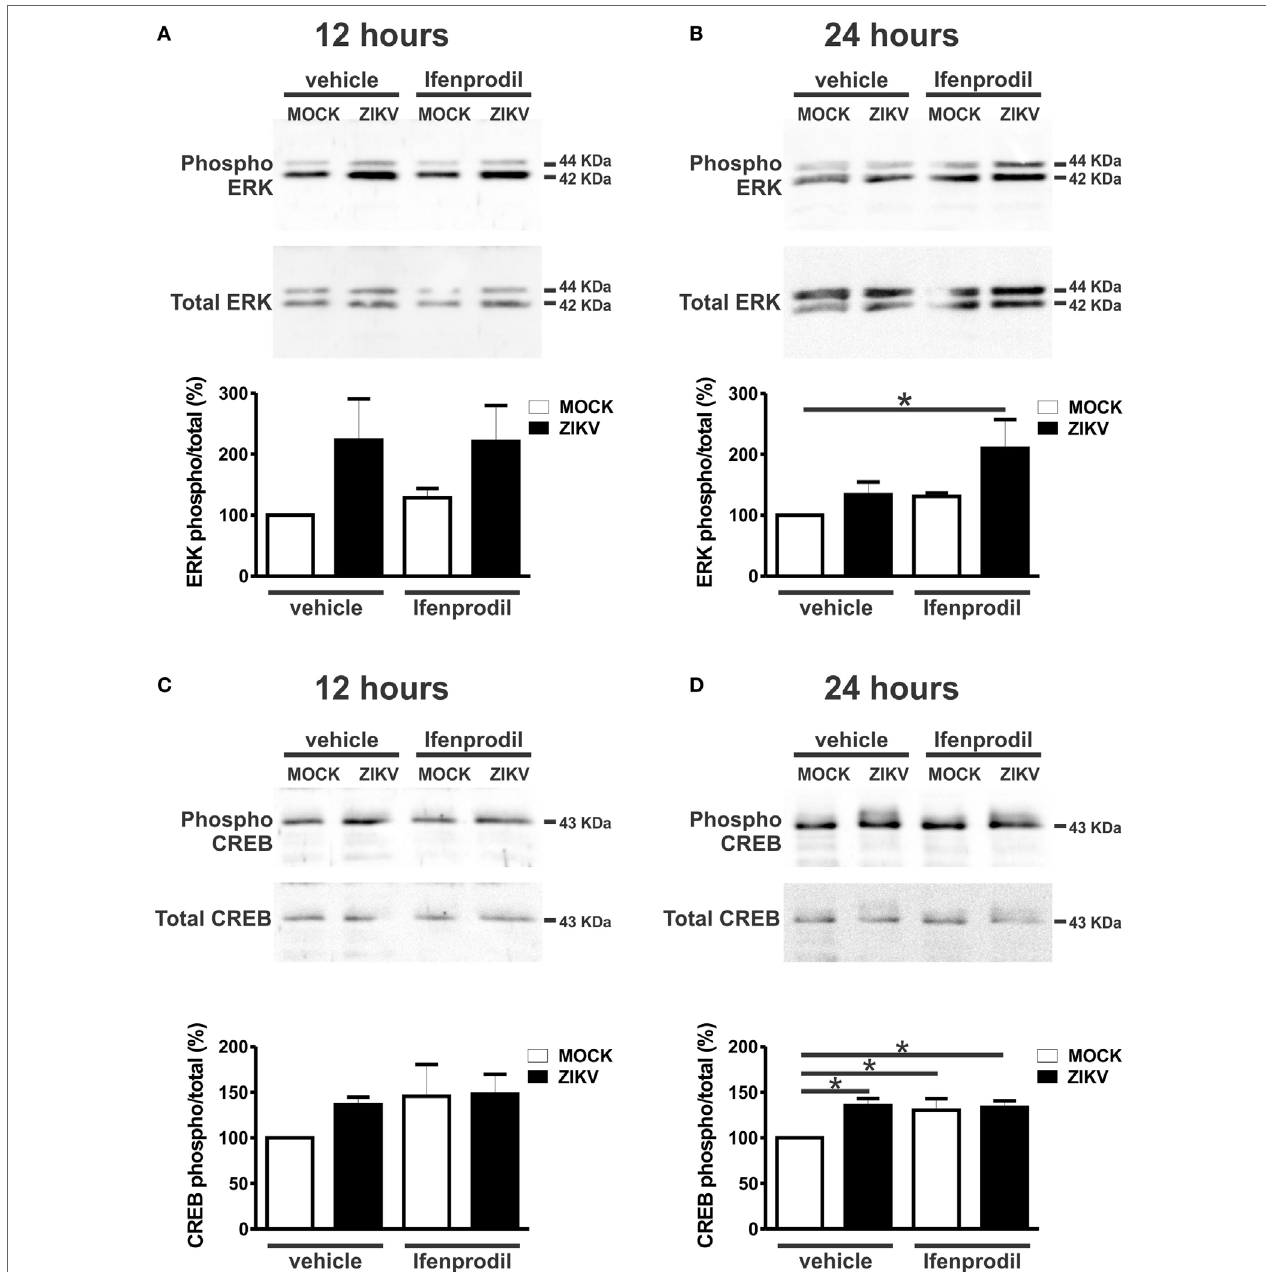
FigUre 6 | Ifenprodil treatment of Zika virus (ZIKV)-infected cultures lead to increased extracellular signal-regulated kinase (ERK) and cAMP response element- binding protein (CREB) phosphorylation. Shown are representative immunoblots for phospho- (upper panel) and total-ERK expression (lower panel) and graphs depicting the densitometric analysis of phospho-ERK normalized to total-ERK expression in primary cultured corticostriatal neurons that were either untreated (vehicle) or treated with 0.01 µM ifenprodil for 12 (a) or 24 (B) hours following MOCK or ZIKV infection. 100 µg of cell lysate was used for each sample. Data represent the means ± SEM, n = 5–6. * indicates significant difference ( p < 0.05). Shown are representative immunoblots for phospho- (upper panel) and total CREB expression (lower panel) and graphs depicting the densitometric analysis of phospho-CREB normalized to total CREB expression in primary cultured corticostriatal neurons that were either untreated (vehicle) or treated with 0.01 µM ifenprodil for 12 (c) or 24 (D) hours following MOCK or ZIKV infection. 100 µg of cell lysate was used for each sample. Data represent the means ± SEM, n = 4–6. * indicates significant differences ( p <